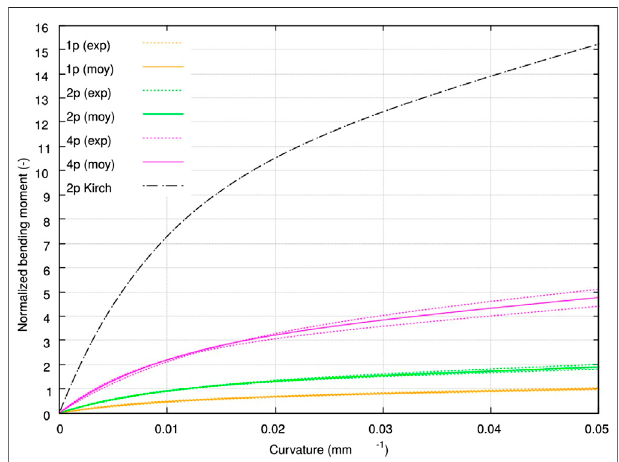
FIGURE 11 | Normalized bending response at T proc for a single ply (1p) and for 2- (2p) and 4-ply (4p) UD stacks, and theoretical response for a ply of double thickness (2p Kirch). Each experimental (exp) curve corresponds to one single test; solid lines (moy) show corresponding average optimized